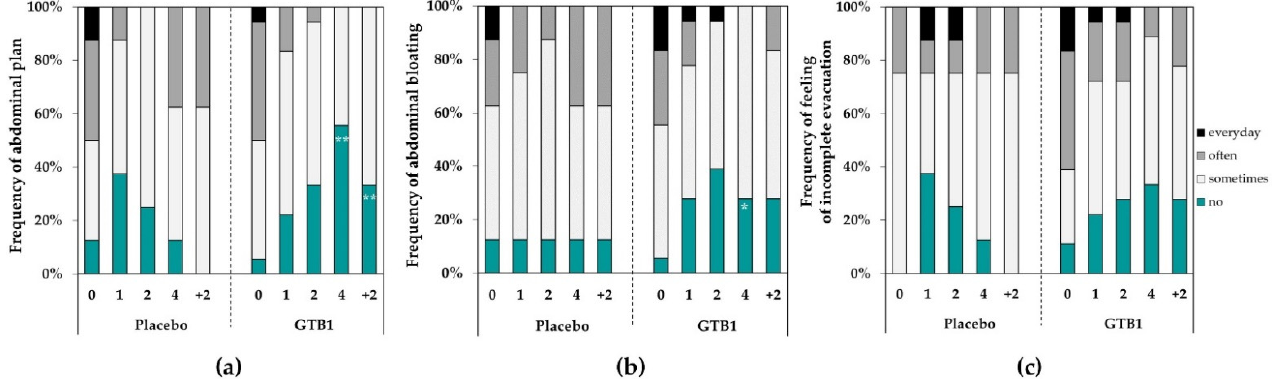
Figure 4. Frequency of intestinal discomfort symptoms during intervention period. ( a ) Abdominal pain; ( b ) abdominal bloating; ( c ) feeling of incomplete evacuation. Data for each visit are shown as % of all subjects. * p < 0.05, ** p < 0.01 as determined by Chi-square